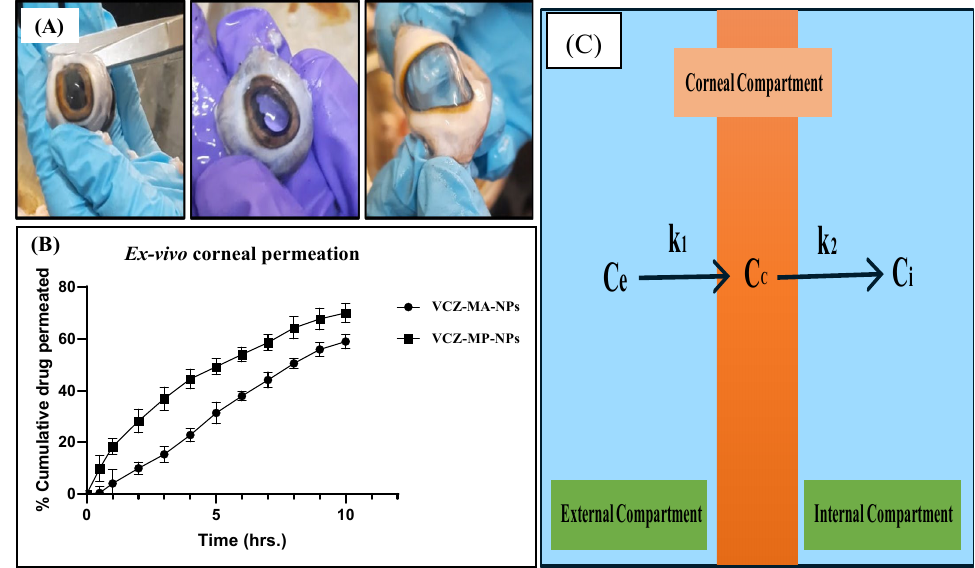
Figure 11. ( A ) Photographs for excision of goat cornea, ( B ) Ex vivo corneal permeation studies of VCZ-MA-NPs and VCZ-MP-NPs on excised goat cornea. Data are represented as mean ± SD ( n = 3) and ( C ) Tricompartmental model of transcorneal permeation study. Ce is constant external or epithelial drug concentration, Cc: variable corneal concentration, Ci: variable internal or endothelial drug concentration, k1 and k2: rate constants from epithelial compartment to cornea and from cornea to endothelial compartment, respectively.